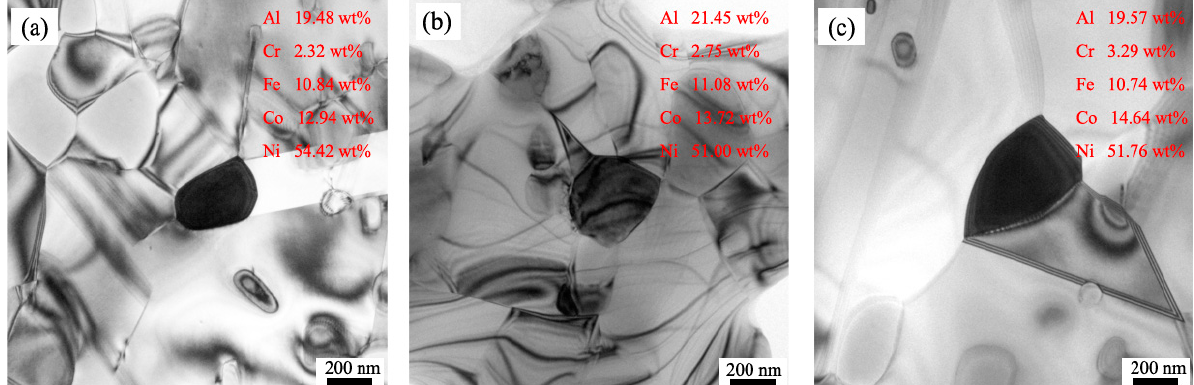
8 of 14 Figure 6. ( a ) STEM images in AR800 sample and corresponding elemental mapping of ( b ) Al, ( c ) Ni, ( d ) Cr, ( e ) Fe, ( f ) Co. Based on the above analysis, it can be seen that in the annealing temperature range of 590 °C to 800 °C, the B2 phase is the main precipitate. Figure 7 compares the chemical composition of the B2 phase in the samples annealed at various temperatures. It was found that annealing temperature has little influence on the chemical composition of the B2 phases. TEM bright field images of the AR800 sample are used to further reveal the nucleation and distribution of B2 precipitates, as shown in Figure 8. The coarse B2 phas- es are favorably precipitated at the grain boundaries. Moreover, fine B2 phases are also